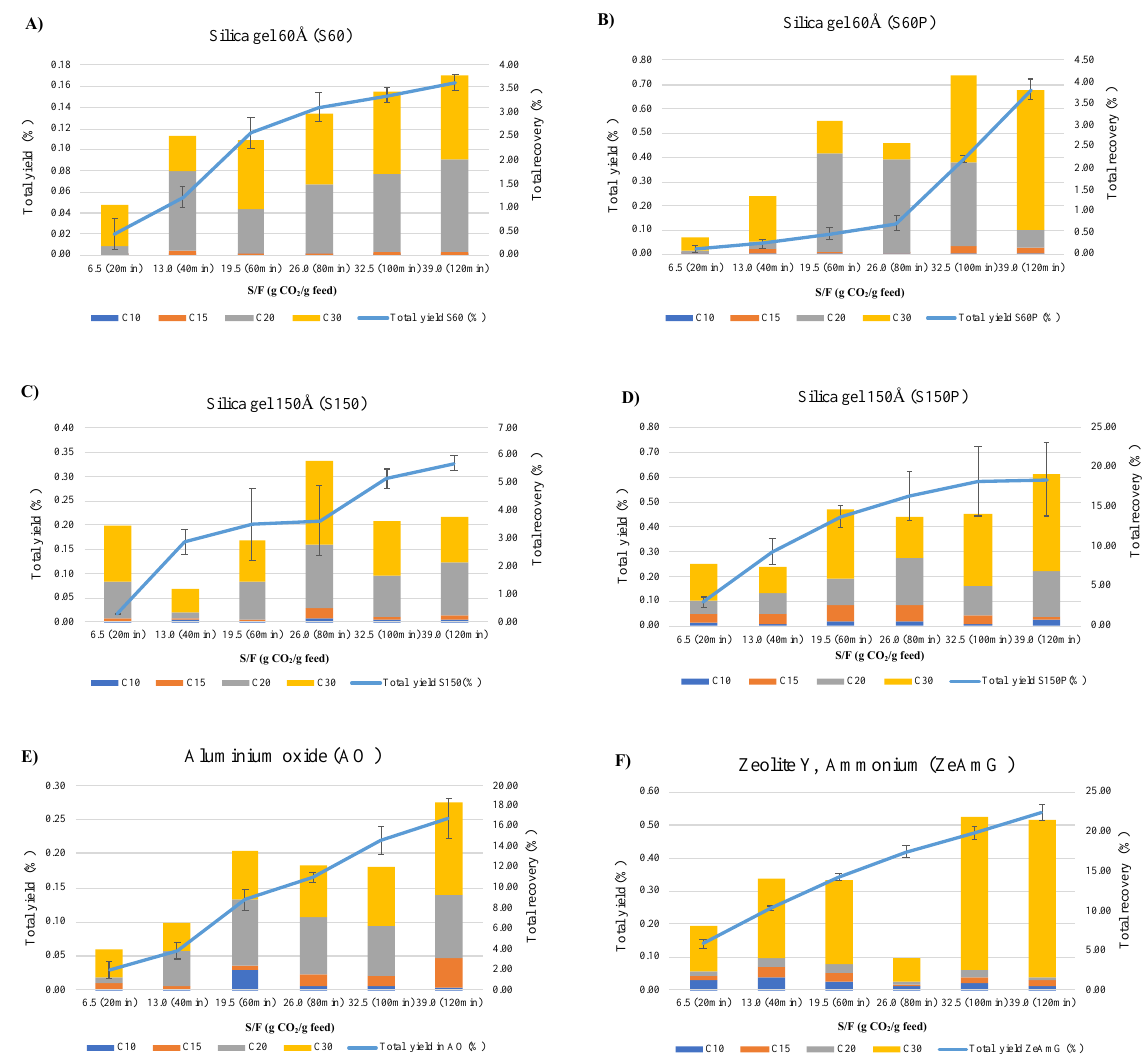
Figure 3. Comparison of total yield (%) and total terpenes recovery (%) in the studied adsorbents ( A ) S60; ( B ) S60P; ( C ) S150; ( D ) S150P; ( E ) AO; and ( F ) ZeAmG vs. S/F ratio.